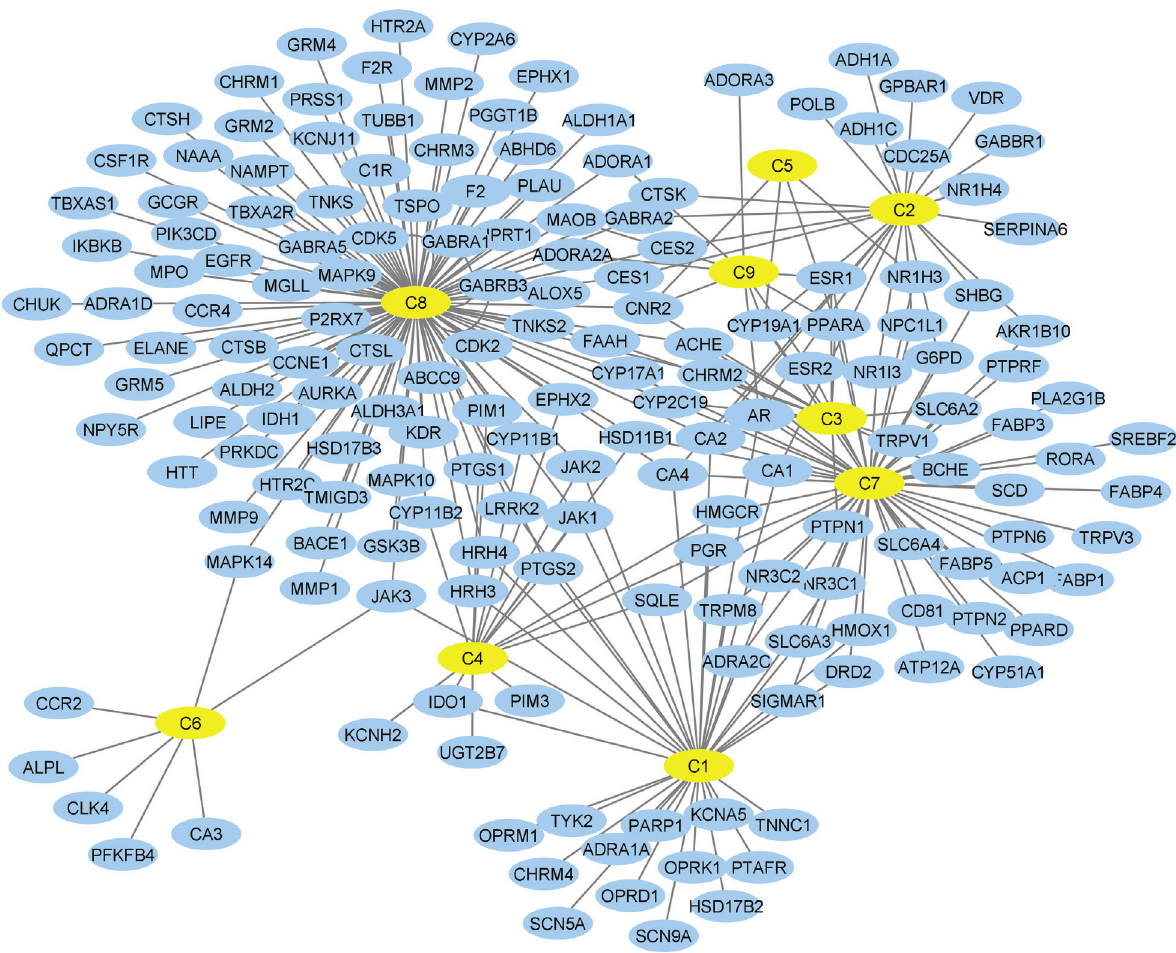
Figure 4. The network interaction between 9 compounds from CSL with targets from